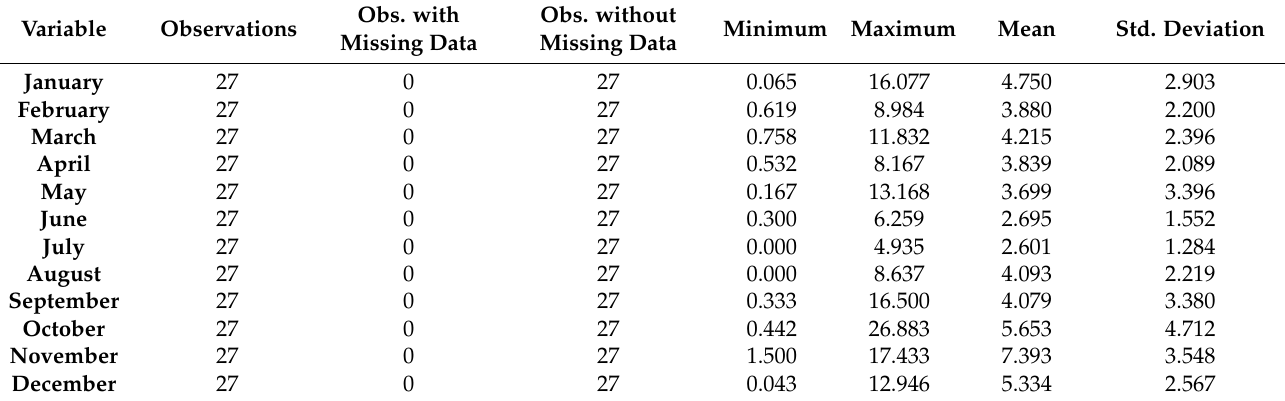
Table 1. Statistical Analysis of Rainfall Data with Mann–Kendall